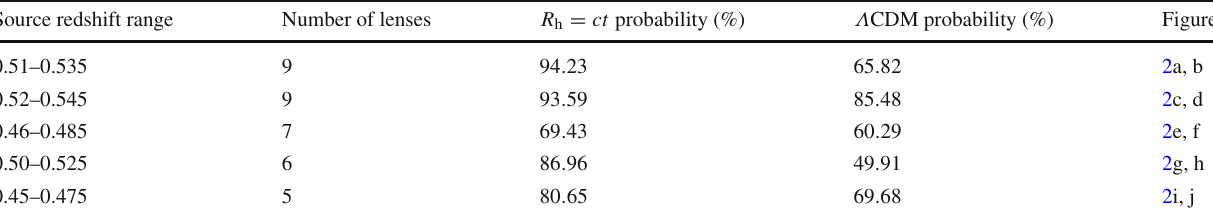
Table 6 Model comparison using strong gravitational lenses with Gaussian processes Source redshift